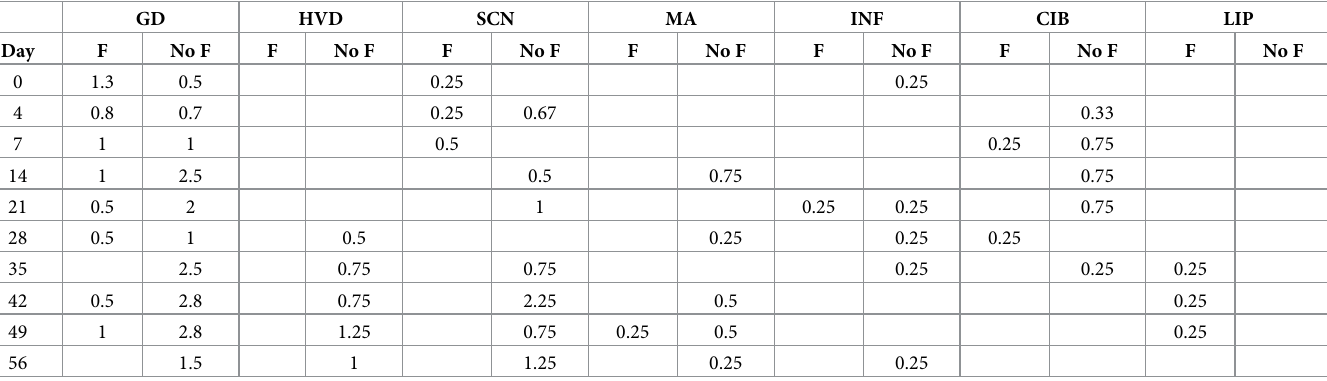
We included ten additional endpoints that we do not routinely measure on wild fish (Table 1). Mortality was recorded daily. Hepatocyte area was measured at six time points, hepatocyte nucleus area at ten time points, and apoptosis at four time points (Table 1). These endpoints were included to understand whether livers of fasting fish decline in size due to atro- phy of hepatocytes, loss of cells via apoptosis or necrosis, or some combination of these pro- cesses. Glutathione and lipid peroxidation (indicated by malondialdehyde) were both measured in liver at 12 time points. The enzymatic antioxidants superoxide dismutase, cata- lase, and glutathione peroxidase, as well as protein concentration, were measured in liver at